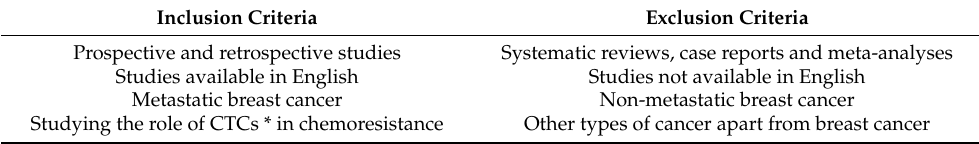
Table 1. Inclusion and exclusion criteria for the analyzed studies. Inclusion